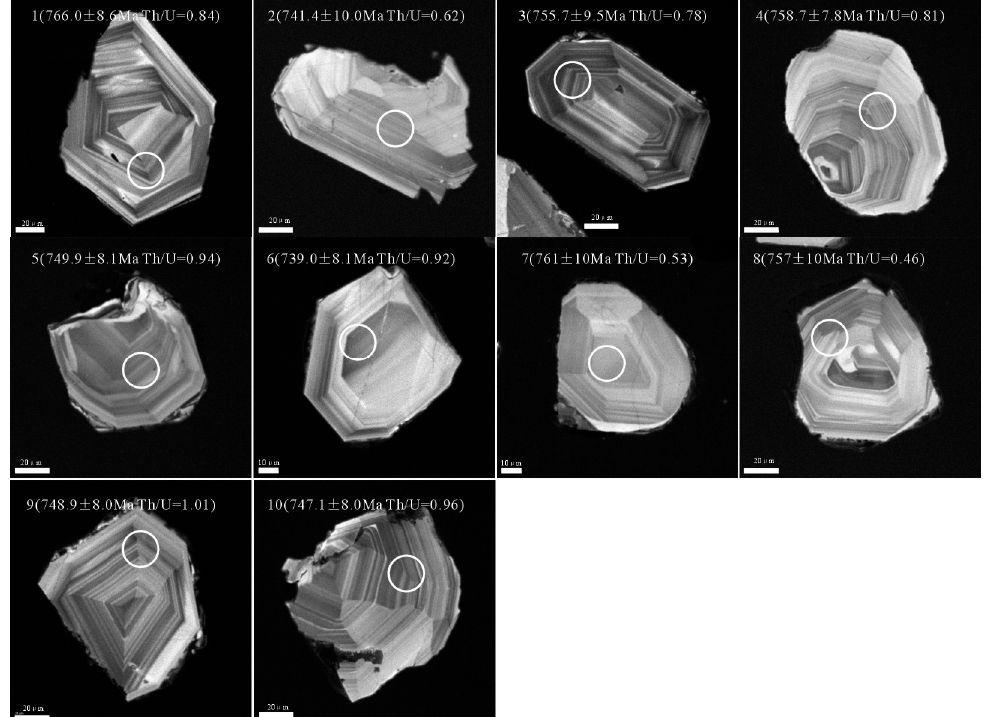
Figure 3. Cathodoluminescence figure of zircons from the Xingdi No.2 gabbro.